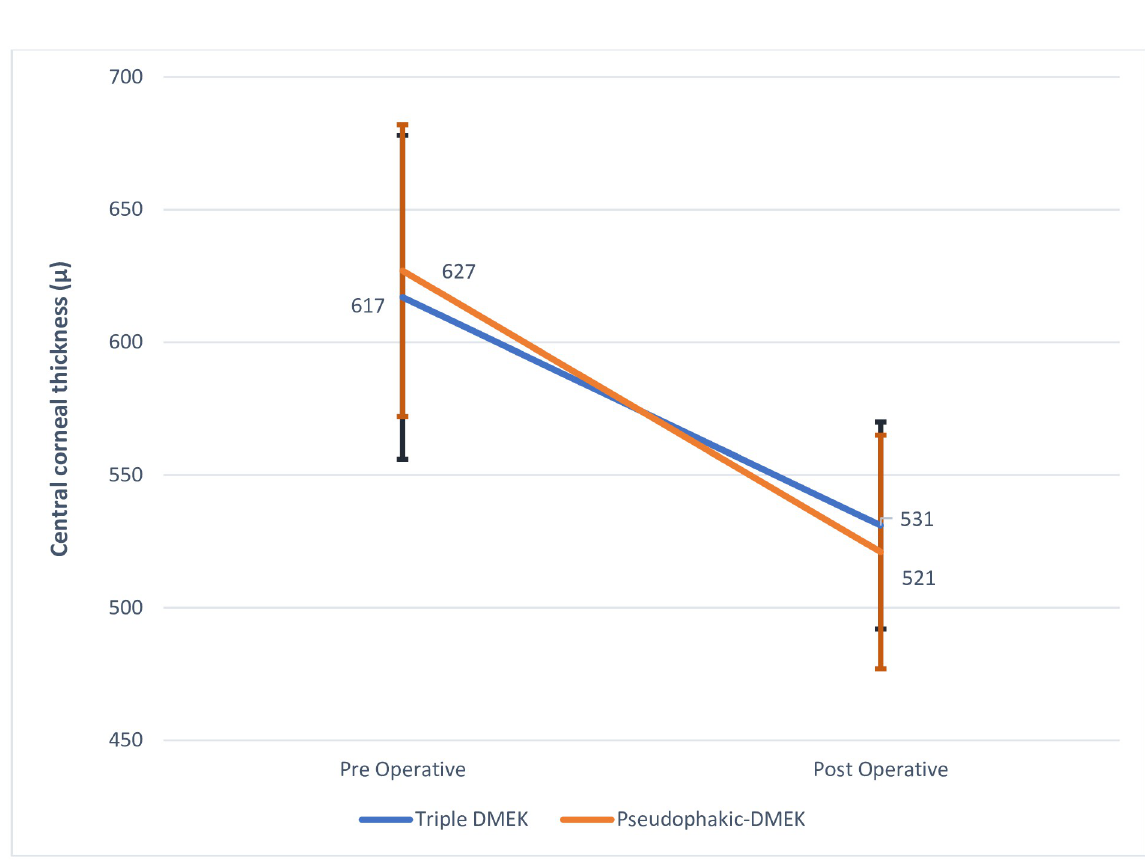
Fig 3. Change in central corneal thickness in the study groups. DMEK, Descemet membrane endothelial